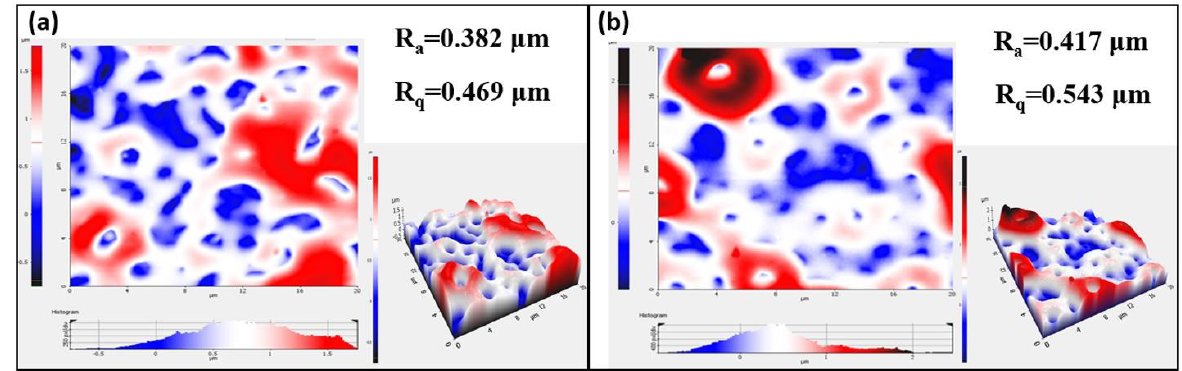
Figure 3. 2D and 3D micrographs obtained via AFM analysis of the titanium samples treated by PEO in different electrolytes ( a ) Bath A and ( b ) Bath B.